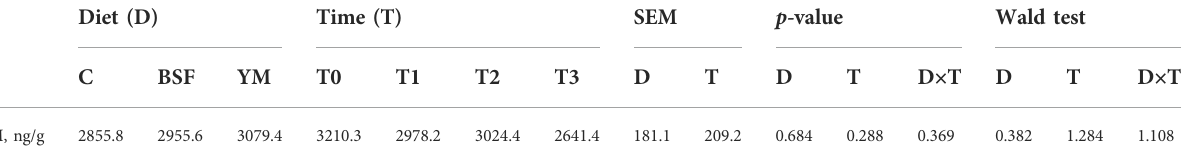
TABLE 5 Excreta CM of the broiler chickens depending on diet, time and their